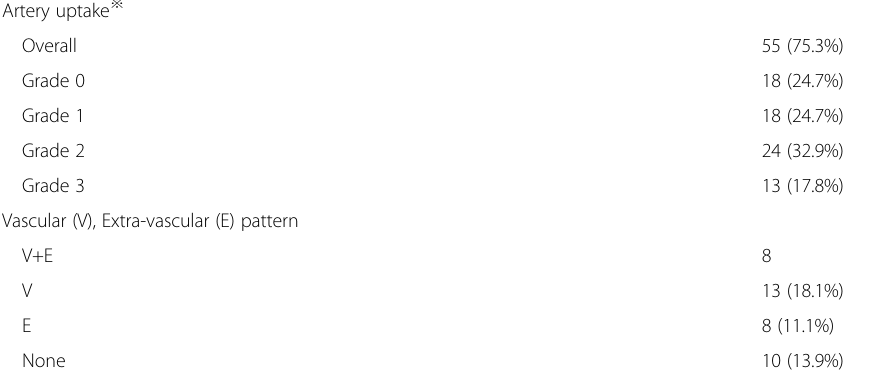
Table 2 Vascular involvement on PET/CT scan ( n = 73) Artery uptake